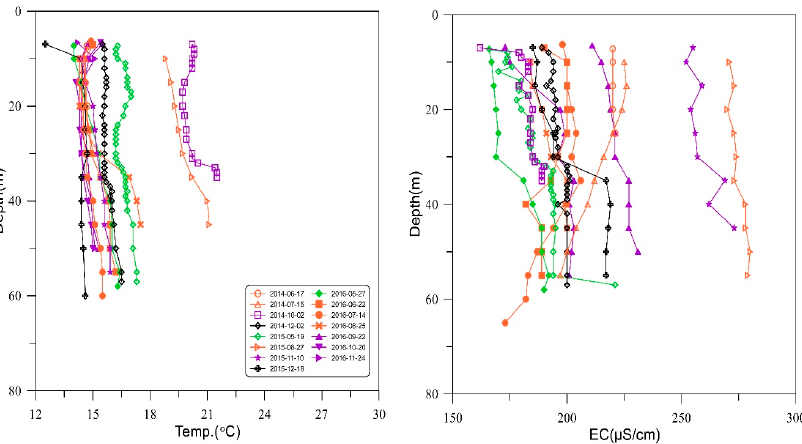
Figure 2. Temperature and EC values with depths.